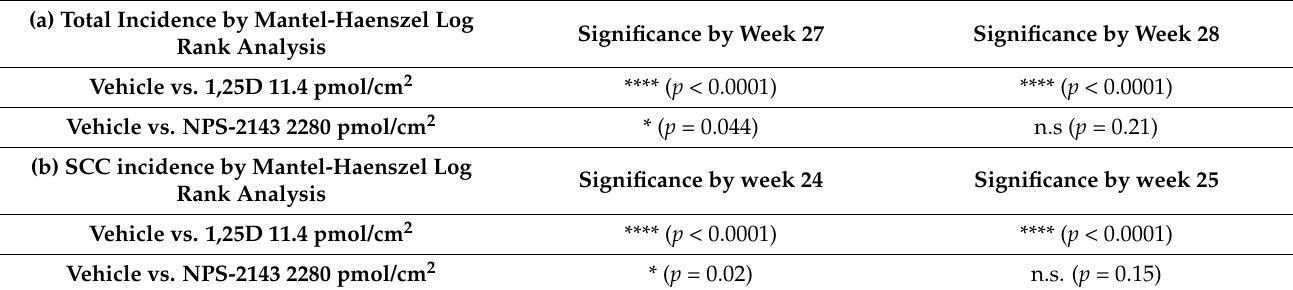
Table 1. (a) Tumour Incidence and (b) SCC incidence analysed using a Mantel–Cox